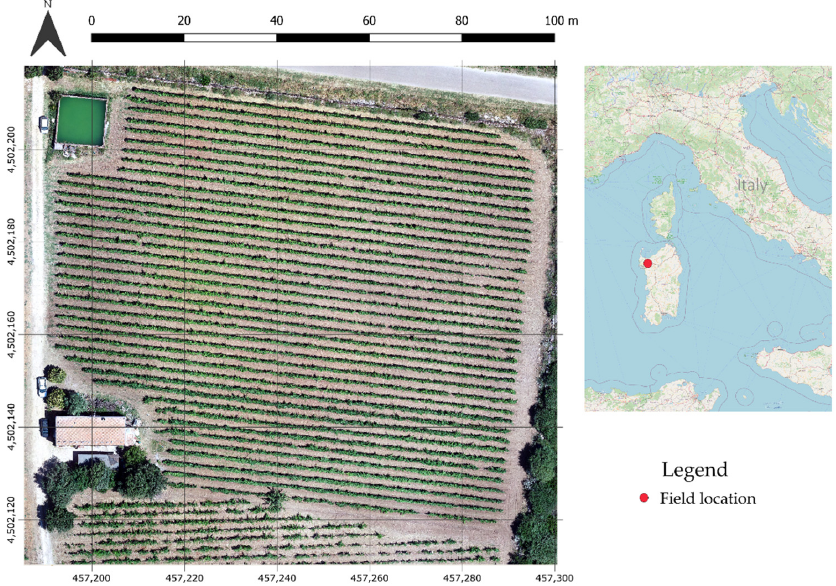
Figure 1. The experimental field located in Usini, North-Eastern Sardinia, Italy (WGS84-UTM 32N–EPSG 32,632 projected coordinate system).